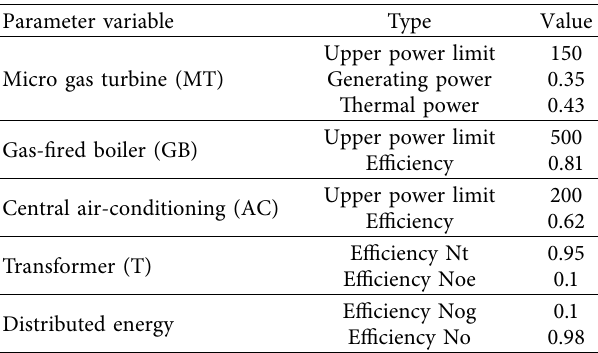
Table 10: Equipment parameters in heat supply